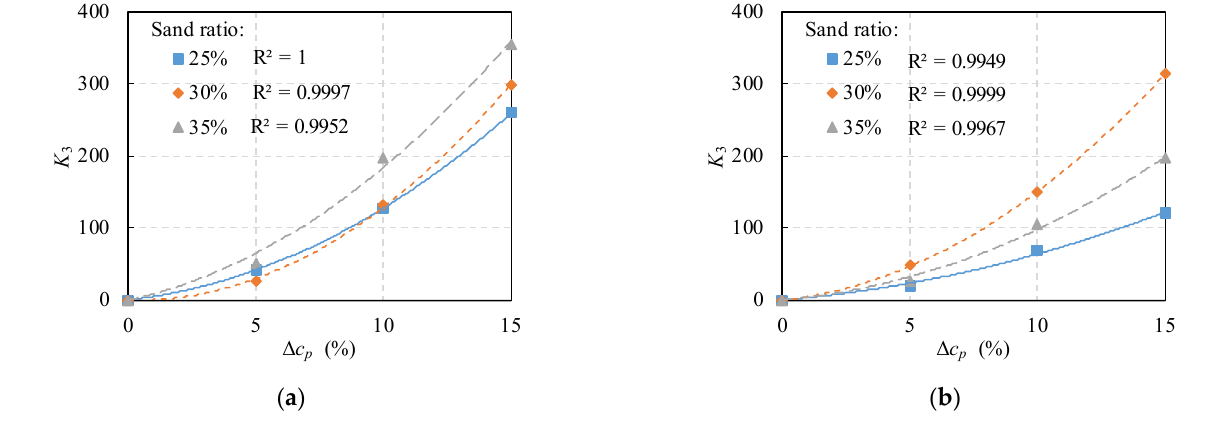
Figure 6. Fitting results of coefficient K 3 with different Δ c p : ( a ) ER–PC; ( b ) PU–PC. Table 6. SCB strength with different sand ratio and content.